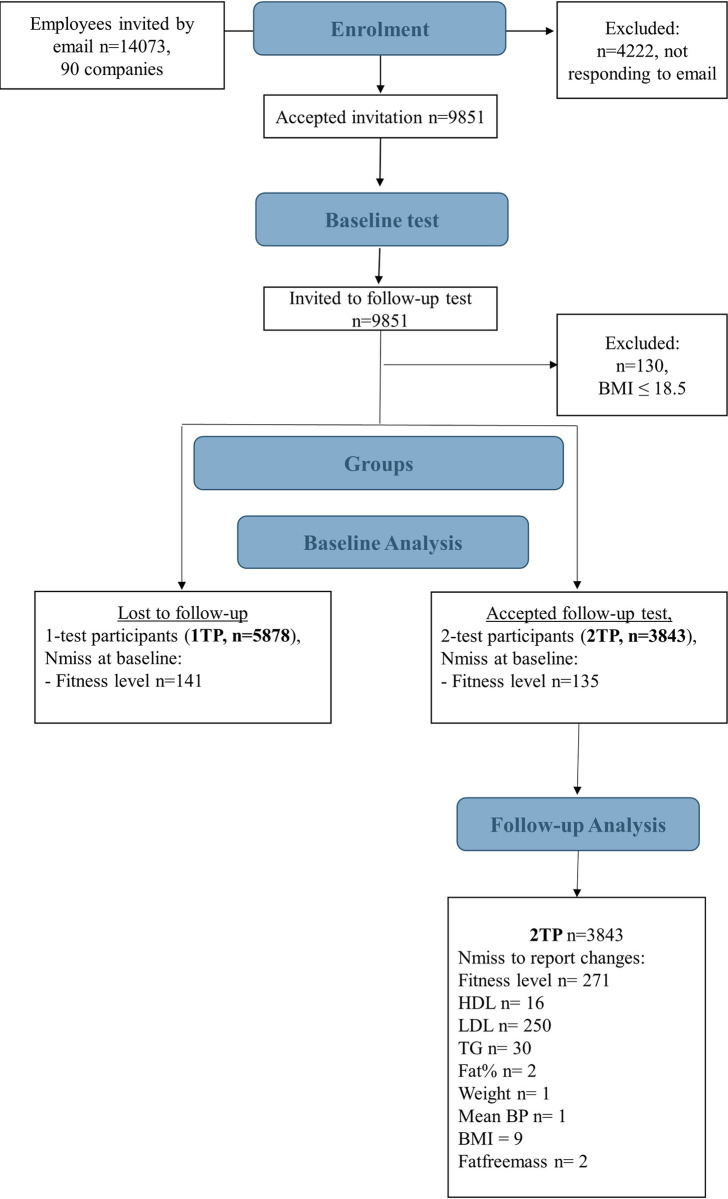
Flow chart of study population.Nmiss number of missing variables, HDL High density lipoprotein, LDL Low density lipoprotein, TG Triglycerides, FAT% body fat percent, MeanBP mean blood pressure, BMI Body mass index.